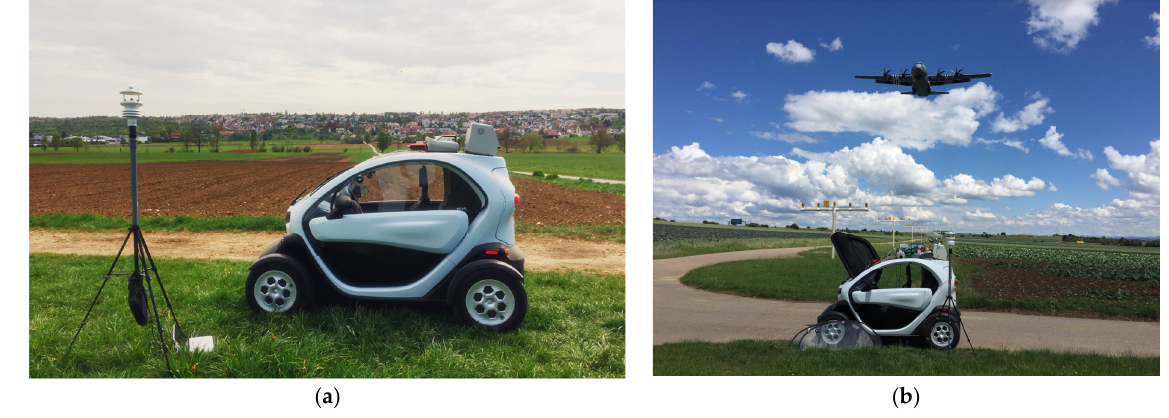
Figure 4. Device setup during ( a ) phase 1 and ( b ) phase 2 of measurements.